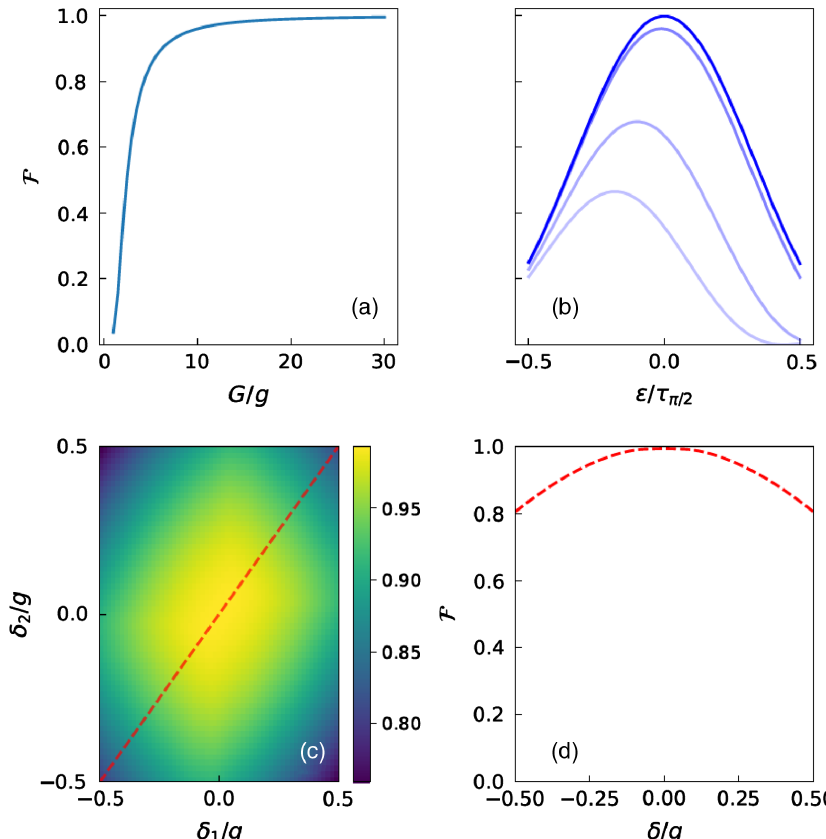
FIG. 6. (a) Lower bound on fidelity for the triple-swap quantum state transfer between two single spins, calculated over all initial spin states and with an initial mechanical state j 0 ; 0 ; 0 i , as a function of G=g . T ¼ 0 K and no decoherence processes are included. (b) As a function of the deviation from the π = 2 pulses. From top to bottom, G=g ¼ 50 , 10, 3, 2. (c) As a function of the detuning, δ 1 and δ 2 , between the waveguide and the two resonator modes, with G=g ¼ 25 . (d) As a function of the detuning δ 1 ¼ δ 2 ¼ δ . The result is also marked with the red dashed curve in (c). Ideal pulse duration and detuning are used unless otherwise